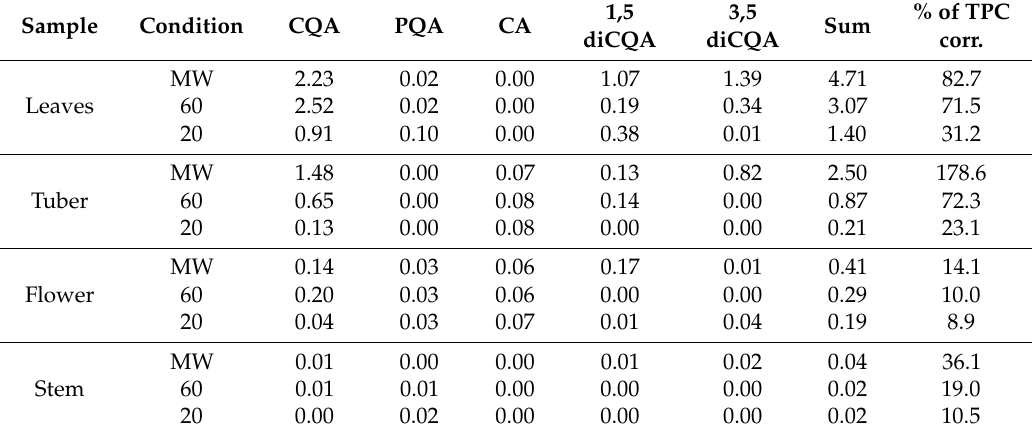
Table 1. Plant organ concentrations (mg g − 1 DS) of main phenolic acids in Jerusalem artichoke, assessed by HPLC-UV analysis of chlorogenic acid (CQA), p -coumaric acid (PQA), ca ff eic acid (CA), and the dica ff eoyl isomers 1,5-diCQA and 3,5-diCQA. Extracts are grouped according to organ and heating conditions (MW or ◦